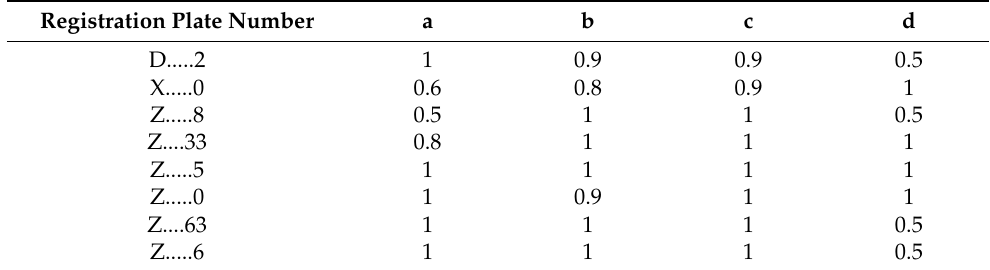
Table 2. Weights assigned to the technical condition of trucks.